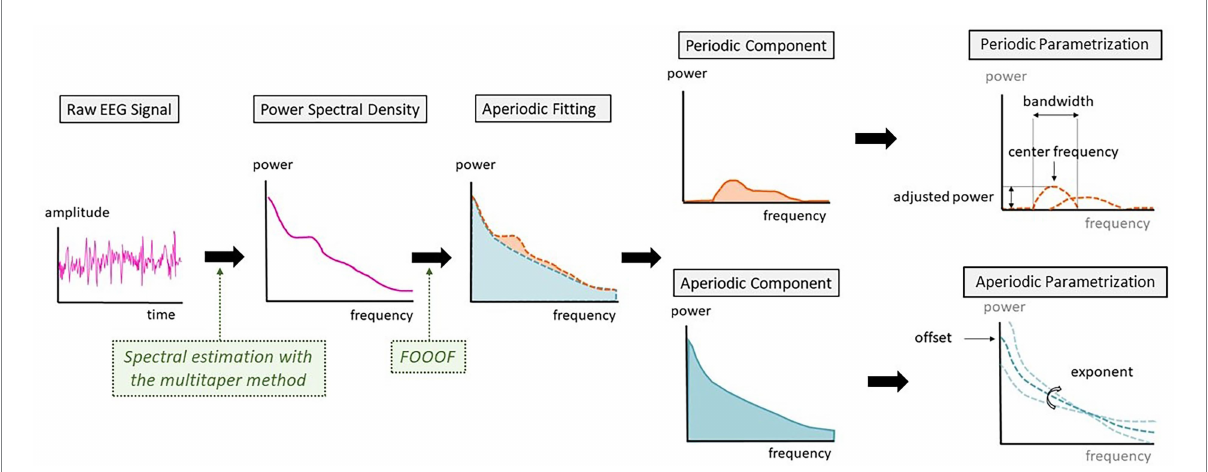
FIGURE 1 Schematic representation of the steps between raw electroencephalography (EEG) signal and the parametrization into periodic and aperiodic